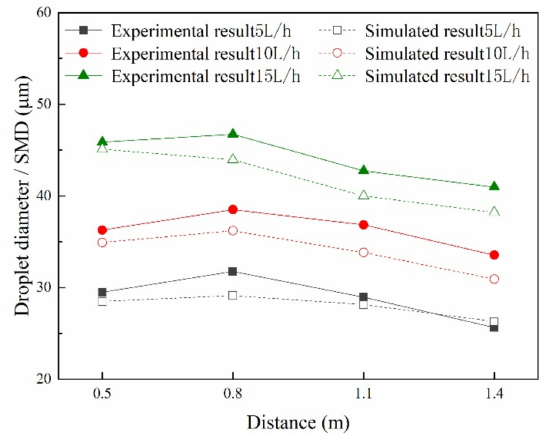
Figure 16. Comparison of experimental and numerical